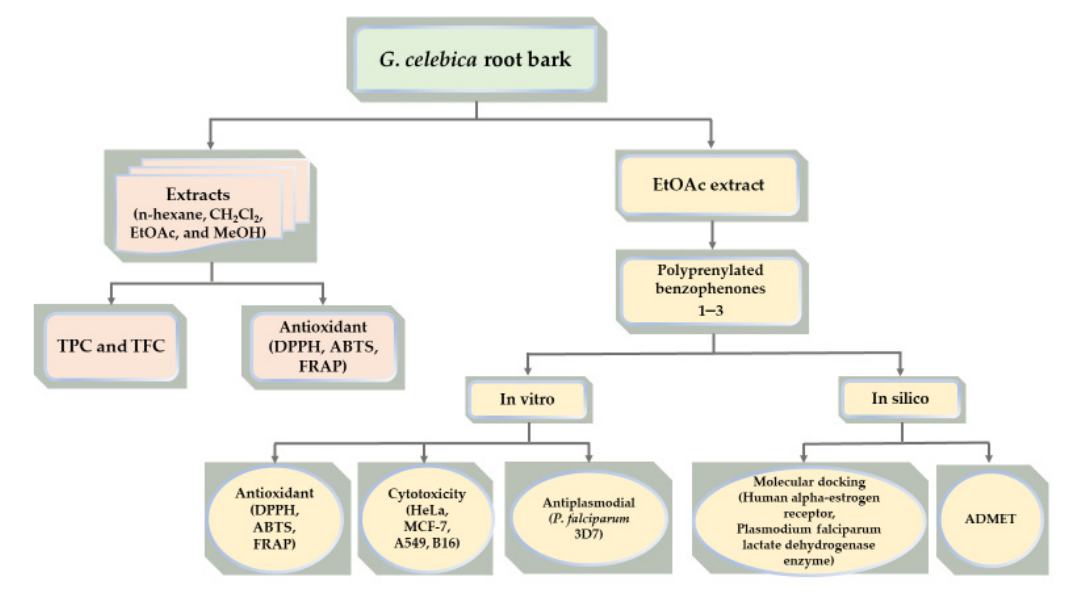
Figure 1. The scheme of the general experimental procedures.